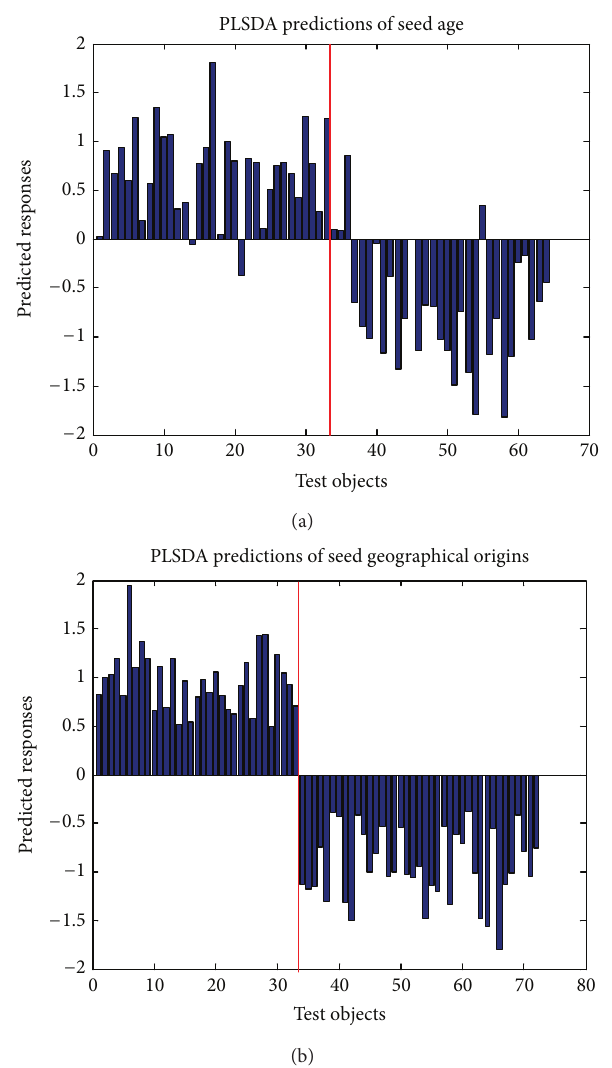
Figure 6: The predictions of seed age and geographical origins by PLSDA with second derivative spectra; the test objects 1–33 are “pos- itives” (with a response variable of 1s) and the others are “negatives” (with a response variable of −